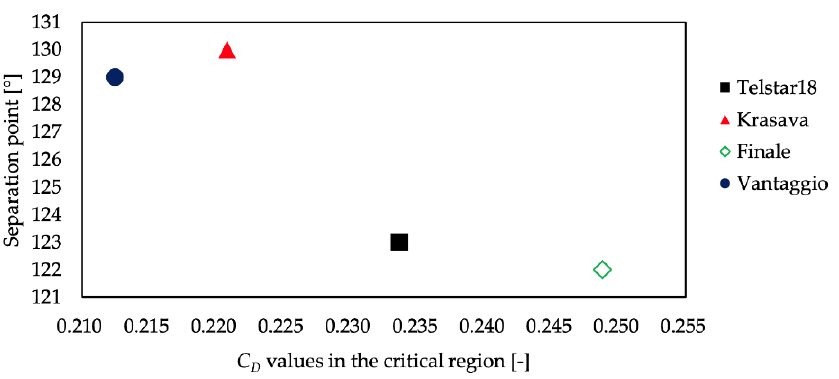
Figure 15. The relationship between the C D values in the supercritical region and the separation position of the oil film experiments.